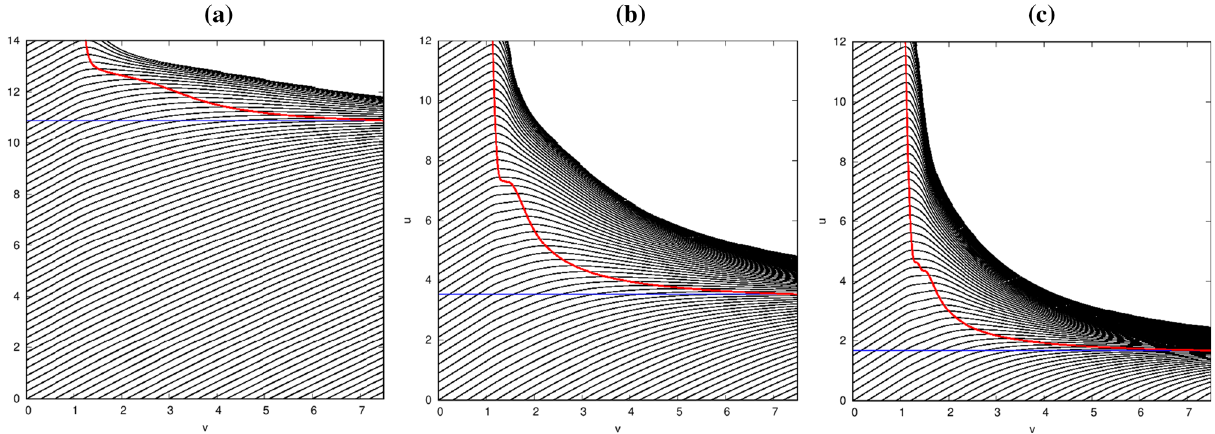
Fig. 3 Penrose diagrams of spacetimes emerging from evolutions with α = − 1 and γ = − 1. The field amplitudes ˜ p s = ˜ p h were equal to a 0 . 02, b 0 . 04 and c 0 . 05